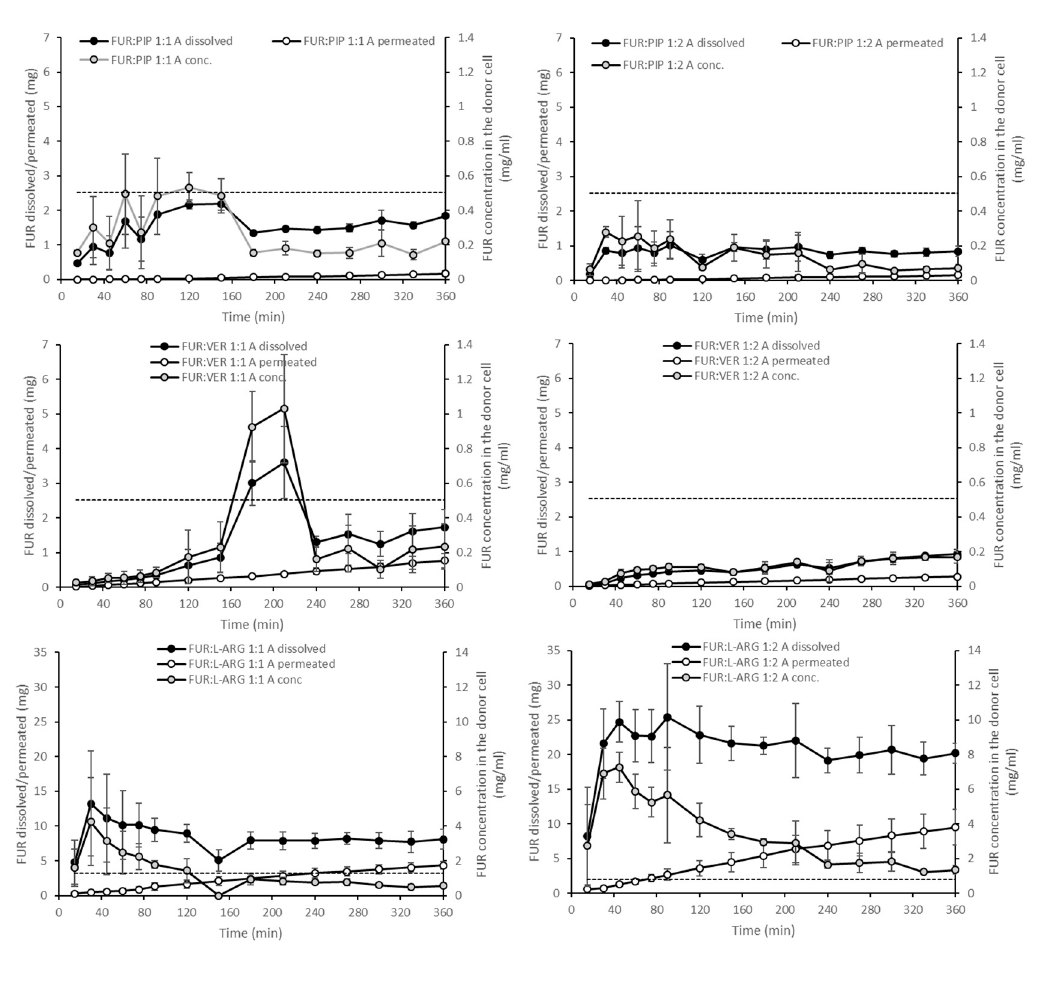
Figure 4. Cumulative amounts of furosemide dissolved and permeated (mg, n = 3 ± sd.) in the simultaneous dissolu- tion/permeation test (left axis). Furosemide concentrations in the donor cell (mg/mL) and the equilibrium solubility of furosemide (right axis): ( a ) crystalline furosemide (FUR) and physical mixtures with piperine (FUR:PIP), verapamil hydrochloride (FUR:VER) and l-arginine (FUR:ARG) at 1:1 and 1:2 molar ratios, and ( b ) amorphous FUR:PIP, FUR:VER and FUR:ARG mixtures at 1:1 and 1:2 molar ratios. Table 3. Area under curve (AUC, mg * min) values for dissolved and permeated FUR during the 6 h dynamic dissolu- tion/permeation test.